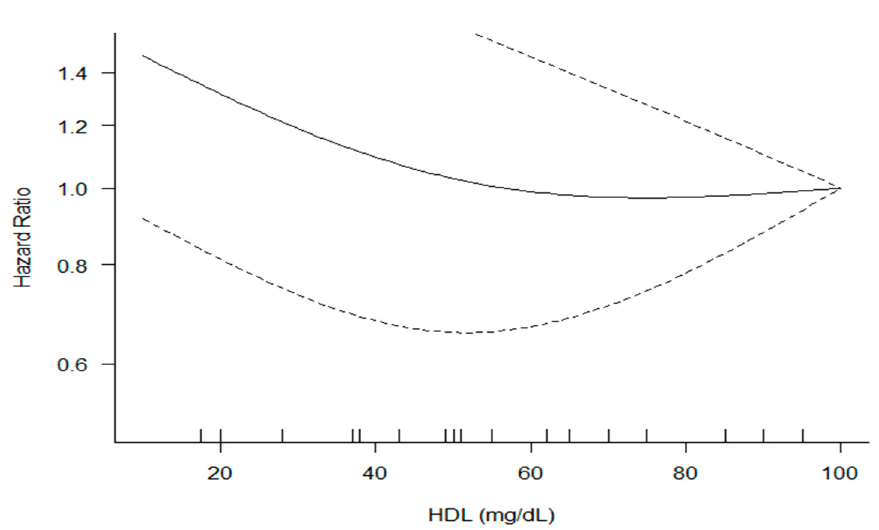
Figure 6. Dose-response meta-analysis between serum High-density lipoprotein (HDL) cholesterol level and the hazard ratio of CVD mortality. The solid line represents point estimates of the association of serum HDL cholesterol and CVD mortality with the use of restricted cubic splines models, and the dashed lines indicate 95%